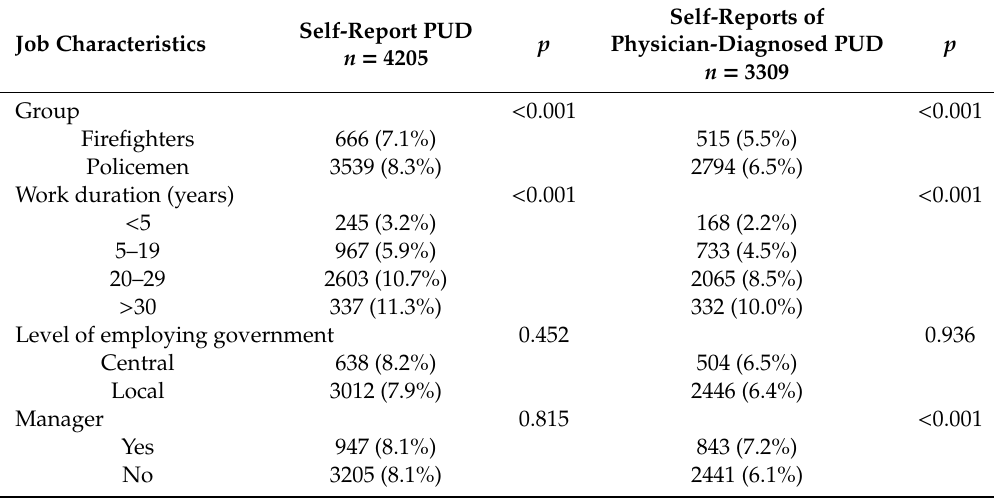
Table 2. Job characteristics by self-reported and self-reports of physician-diagnosed